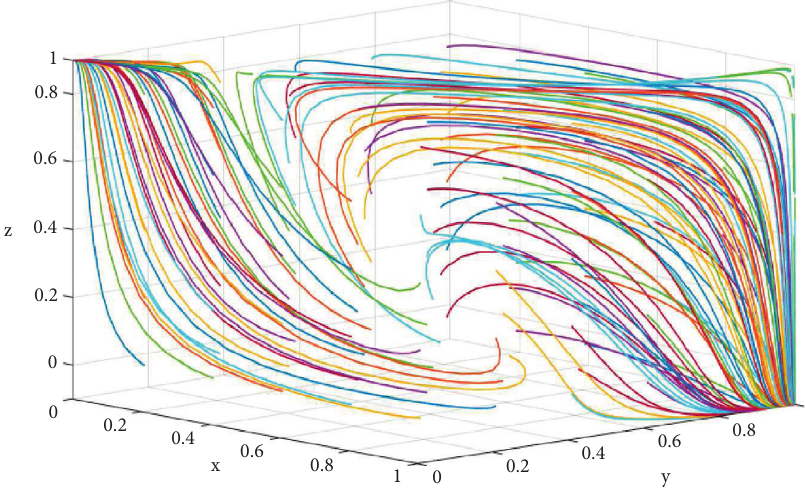
Figure 5: The simulation results of array